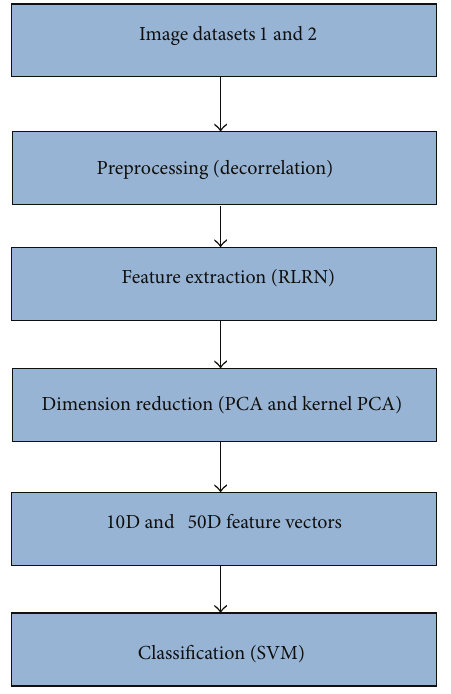
Figure 1: Proposed algorithm